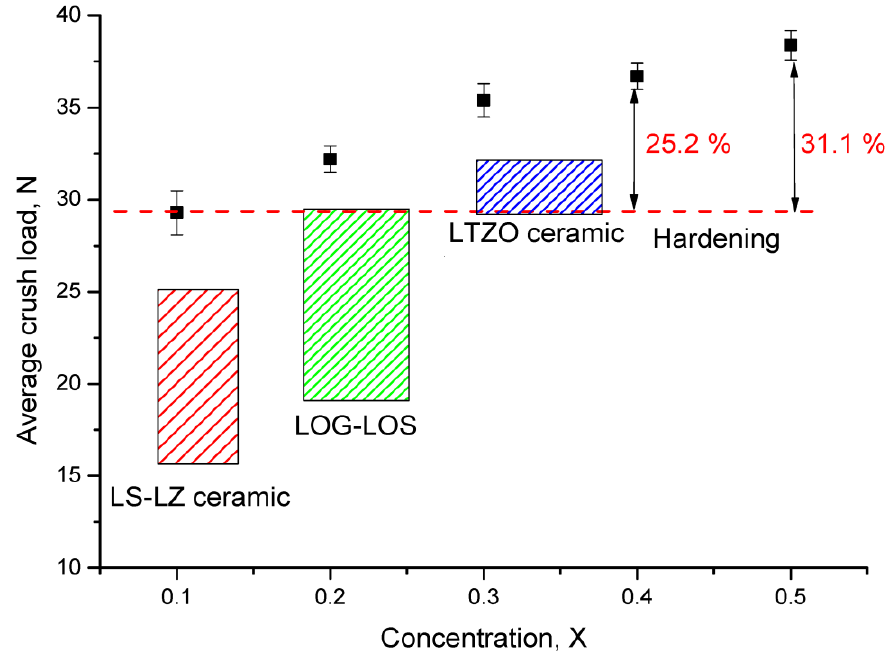
Figure 5. Results of strength measurements for single compression resistance.